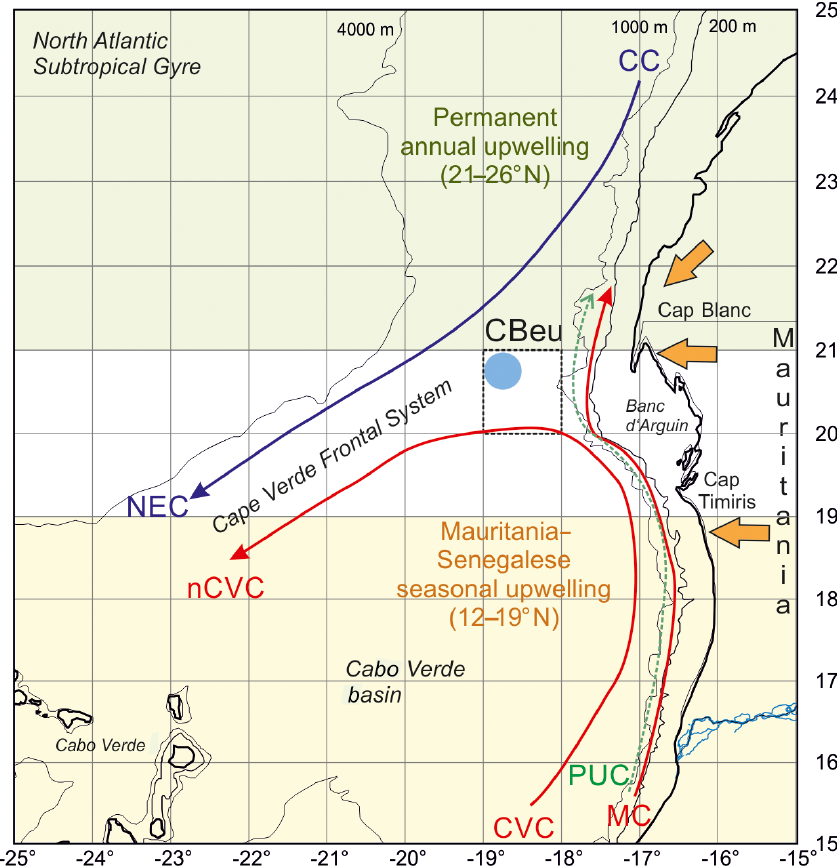
Figure 1. Map of the study area showing the location of trap site CBeu (full light blue dot), surface currents and main wind system. Surface currents (Canary Current, CC, violet line; North Equatorial Countercurrent, blue arrow; Mauritanian Current, red arrow), North Equatorial Current (NEC), Cape Verde Current (CVC), north Cape Verde Current (nCVC) and Poleward Undercurrent (PUC) are depicted after Mittelstaedt (1983, 1991) and Zenk et al. (1991). The Cape Verde Frontal Zone (CVFZ) builds at the confluence of the NACW and the SACW (Zenk et al., 1991). Trade winds and the Saharan air layer are represented by orange arrows (Nicholson, 2013). The upwelling zones are depicted after Cropper et al.